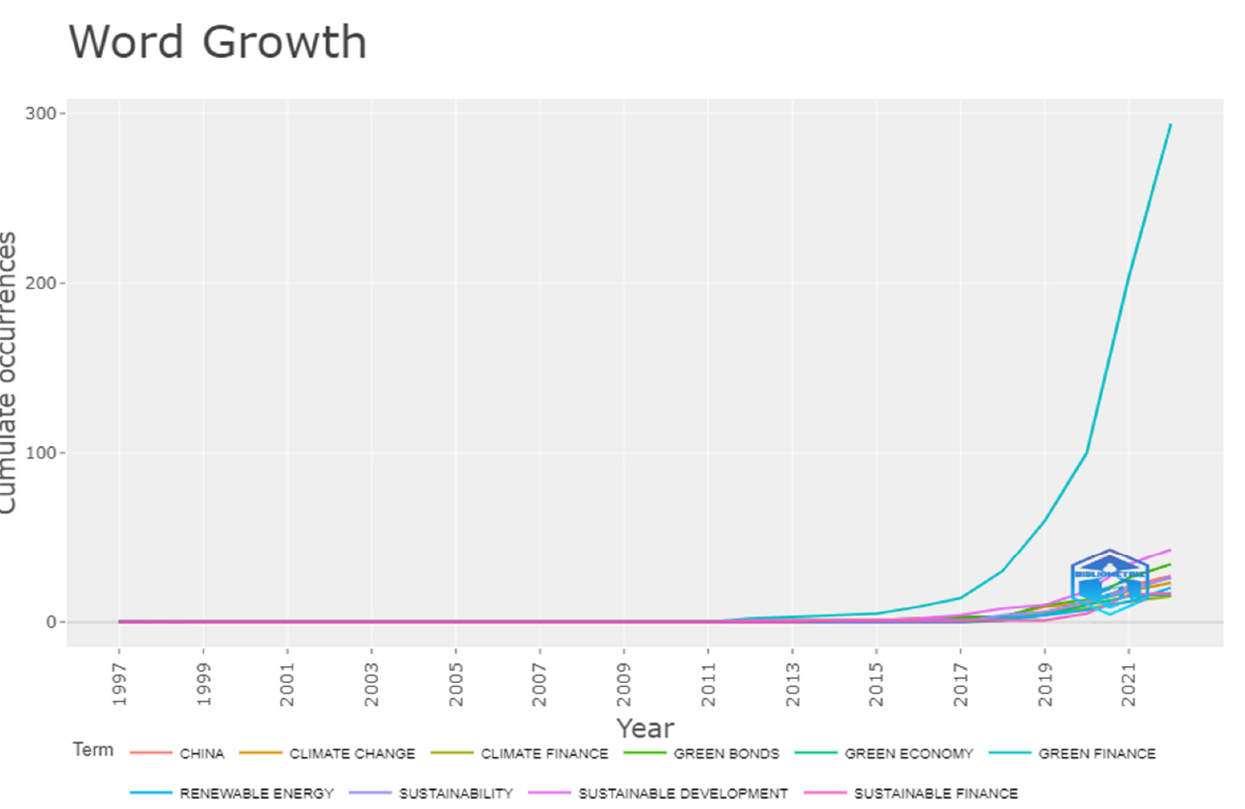
Figure 3. Keywords’ growth over time.